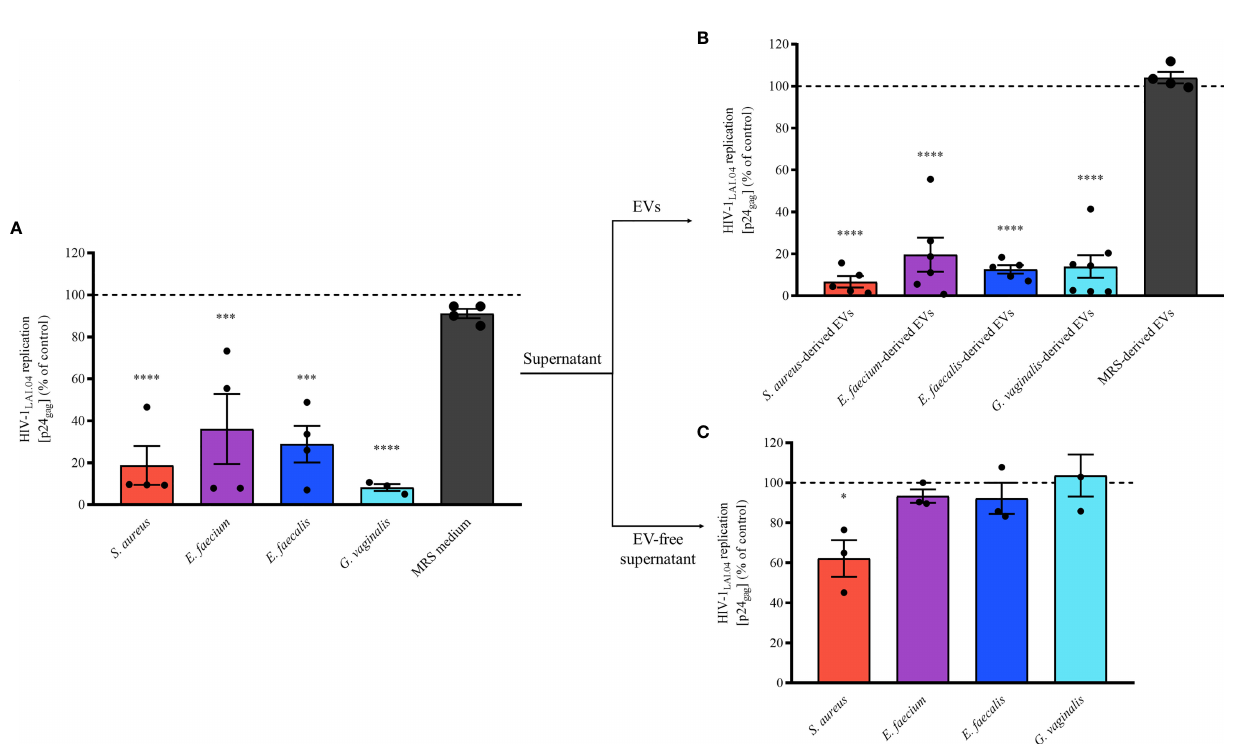
FIGURE 2 | Antiviraleffect of bacterial-derived supernatants, EVs, and EV-freesupernatants. A mixture ofHIV-1 LAI.04 andbacterial-derived supernatants (0.5%), EVs (1×10 10 EVs/mL), orEV-free supernatants (0.5%)incubated for 1h was added to MT-4 cellcultures. Cellswere washedand cultured for 3 daysin thepresence ofbacterial supernatants, EVs, orEV-free supernatants. In control experiments, EV-free, particles isolated from fresh MRS medium, and MRS medium were testedas well. Replication of HIV-1 was evaluatedfrommeasurements of the capsid protein p24 gag , in the cellculture medium; dataare presented as percentages of HIV-1 replication compared with untreated controls. (A) The effects ofbacterialsupernatants (0.5%) derived from S. aureus , E.faecium , E.faecalis, G.vaginalis , andMRS medium(0.5%)onHIV-1 replication inMT-4 cells. (B) The effects of1×10 10 EVs/mL bacterial EVs derived from S. aureus , E. faecium , E.faecalis, G. vaginalis , and MRS medium-derivedparticles onHIV-1 replication inMT-4 cells. (C) The effects of bacterial EV-free supernatants (0.5%, after pulling downEVs byultracentrifugation)derivedfrom S. aureus , E. faecium , E.faecalis , and G.vaginalis on HIV-1 replication in MT-4 cells. Presented are means±SEM from at least three independent measurements. Asterisksindicate statistical signi fi cance by one-way ANOVA multiplecomparisonwith Dunnett ’ s correction (*p<0.05, ***p<0.001,